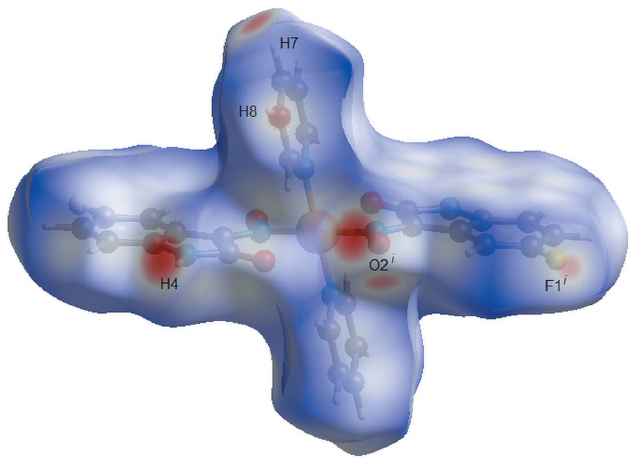
Figure 7 Graphical representation of the Hirshfeld surface ( d norm ) for the title compound. The surface is drawn with transparency and simplified for clarity. The surface regions with strongest intermolecular interactions are drawn in magenta and the respective atoms are labelled. [Symmetry code: (i) (cid:5) x + 3 , (cid:5) y + 3 , (cid:5) z + 1.] 2 2